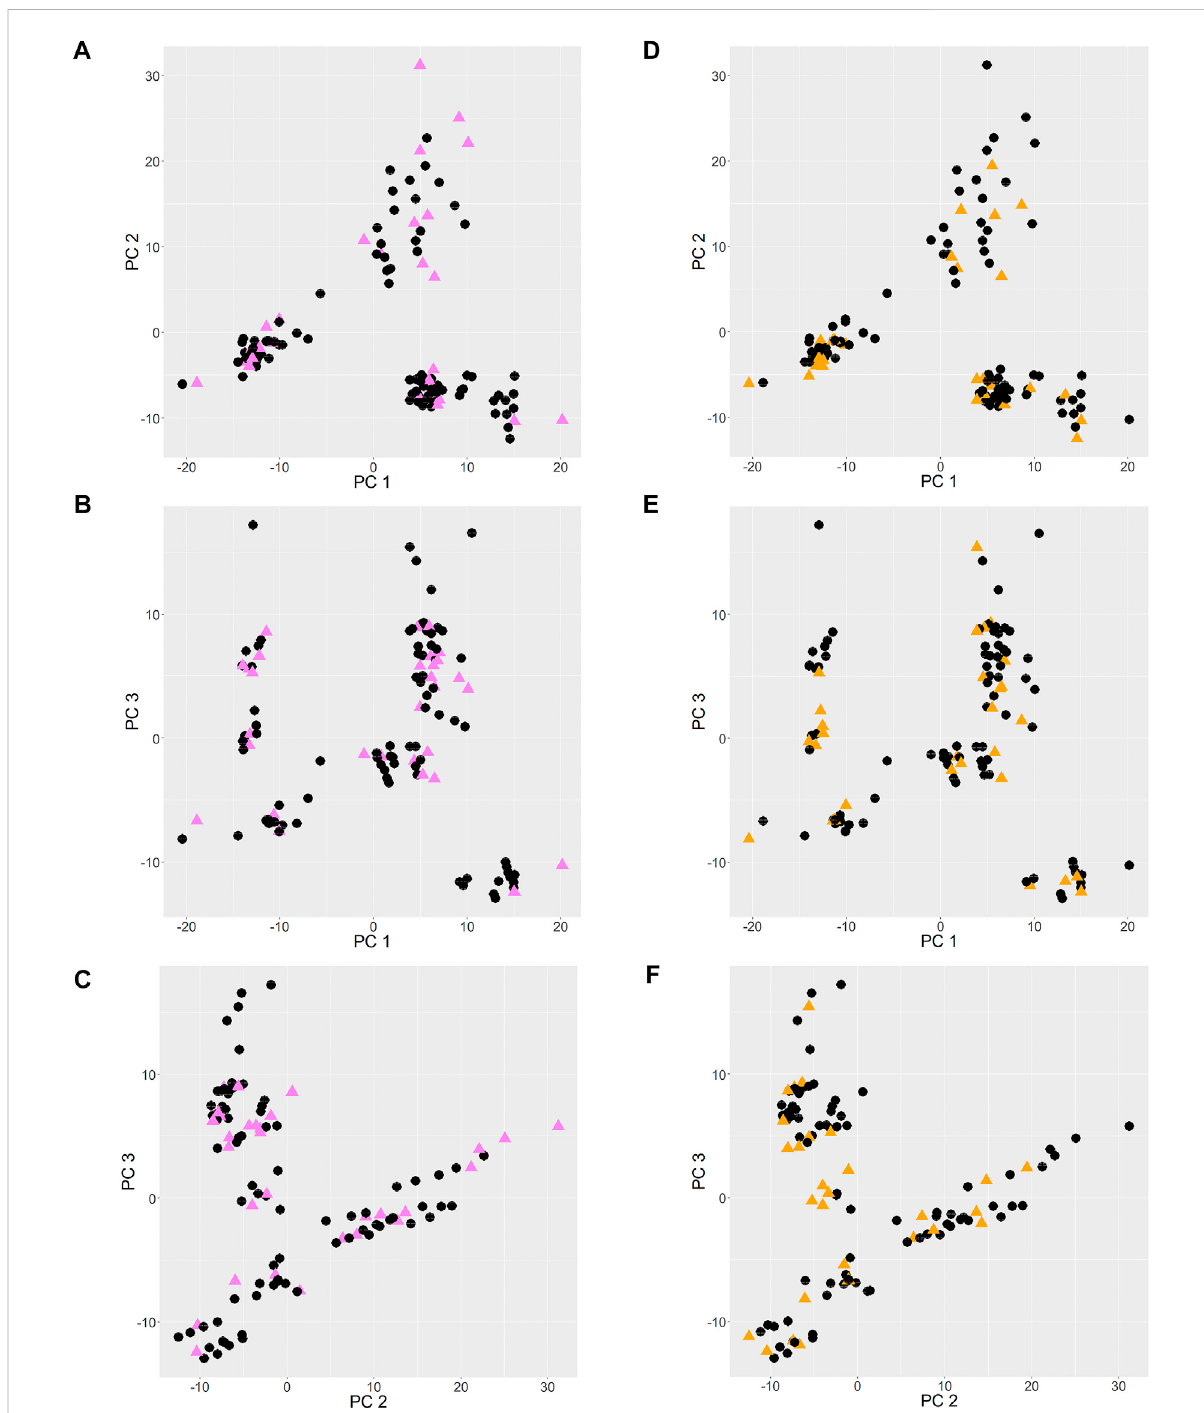
FIGURE 2 PCA score plots. (A – C) : training and validation set 1 entries are shown as black circles and pink triangles respectively. (D – F) : training and validation set 2 entries are shown as black circles and orange triangles